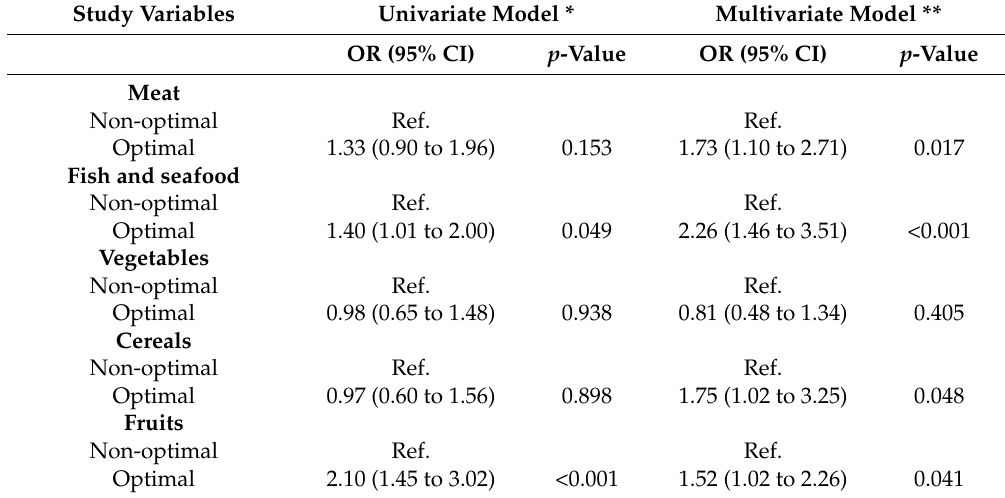
Table 3. Odds ratios for “sufficient” physical activity in the study participants; Croatia ( n =